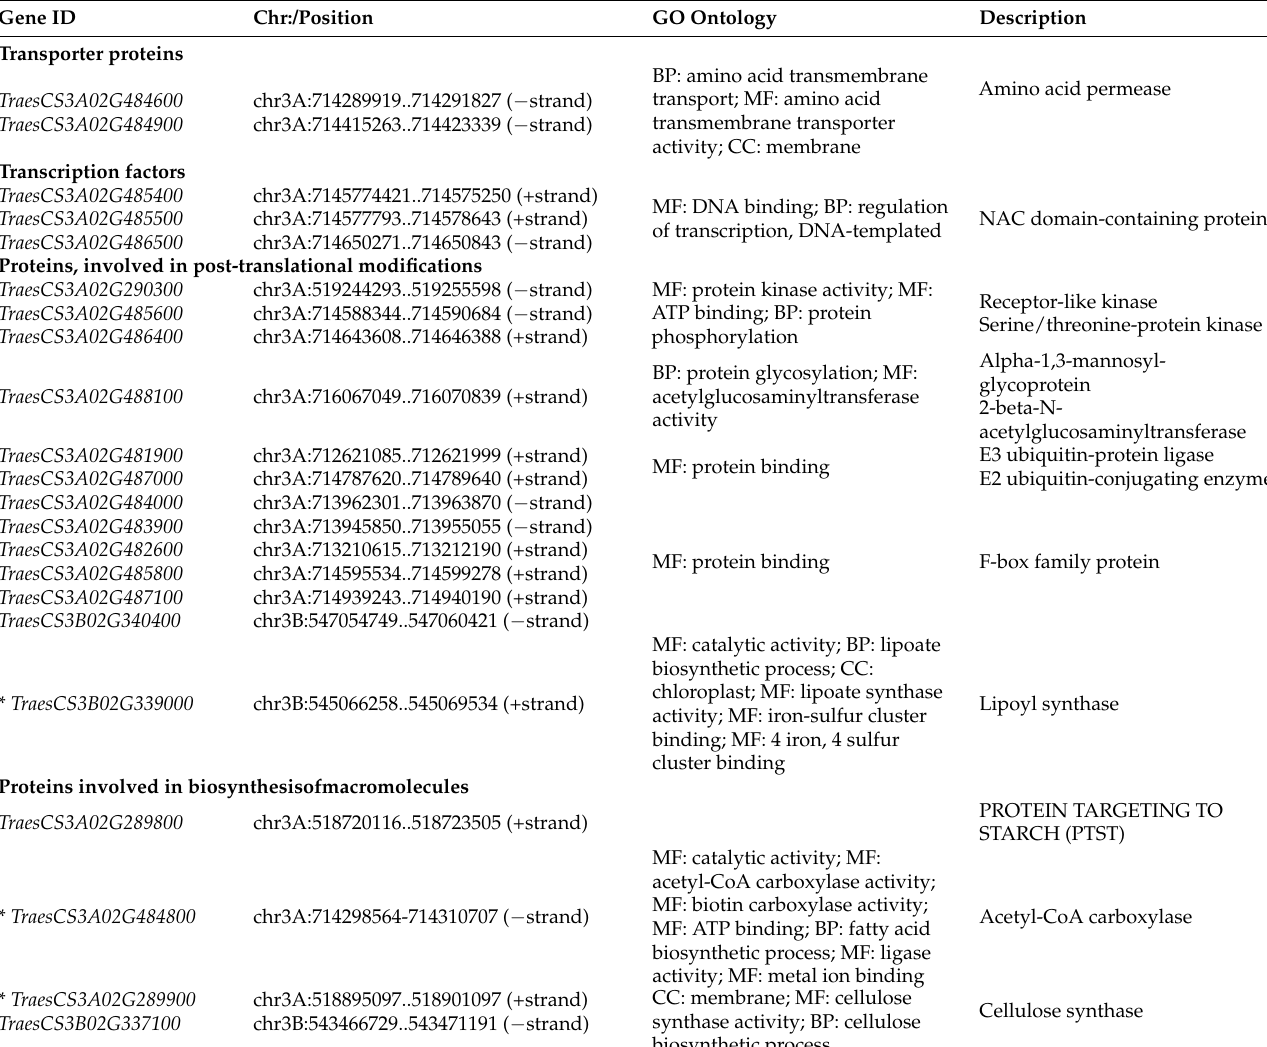
Table 2. Potential candidate genes underlying GPC based on IWGSC RefSeq annotation